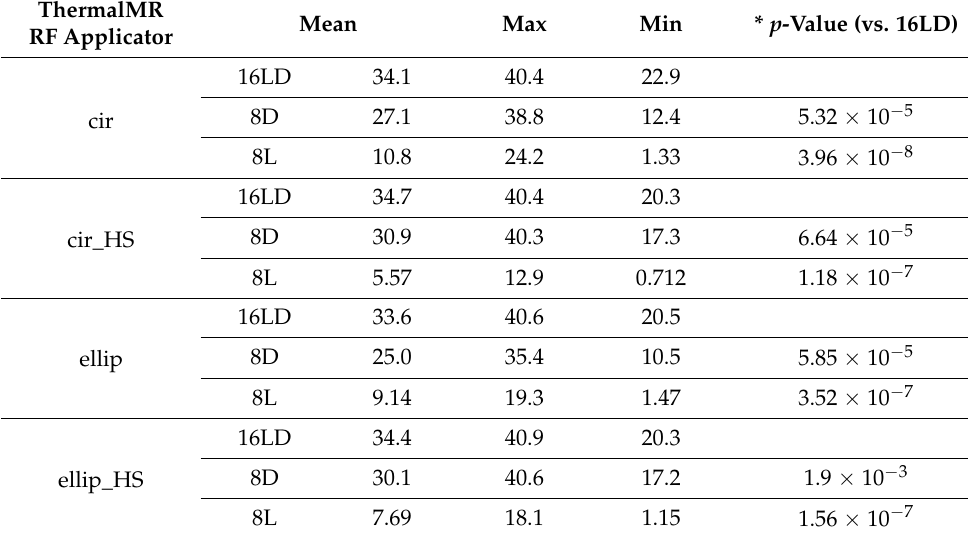
Table 3. Summary of statistical analysis of the targeted RF heating performance of the ThermalMR RF applicators using the metric total SAR 10g inside the tumor